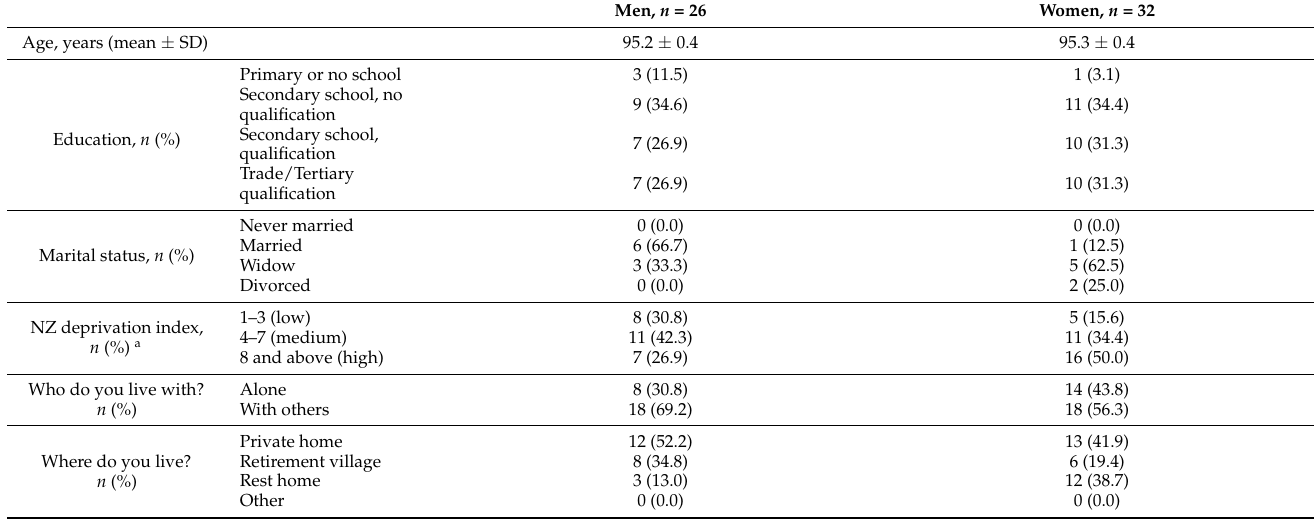
Table 2. Demographic Characteristics, Physical Function and Nutrient Intake in Non-M¯aori